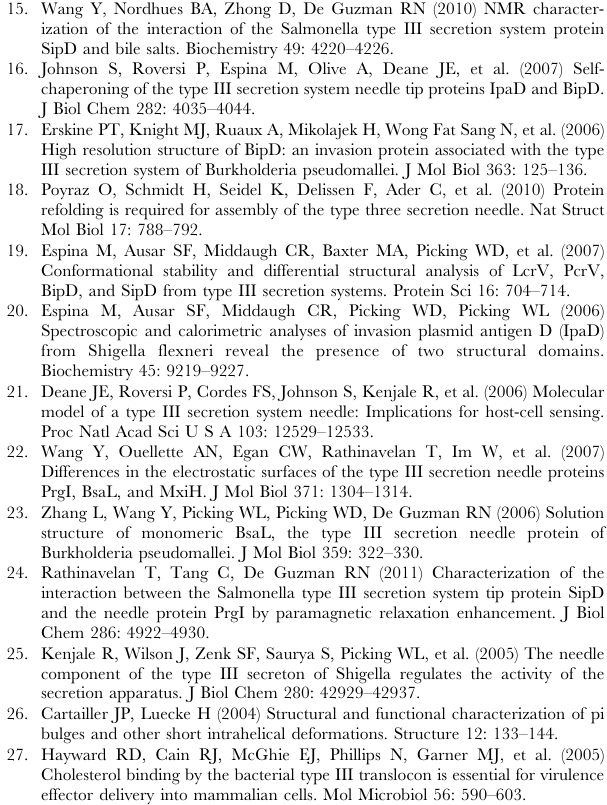
A and B show a p -bulge, chain C and D are partially destabilized and kinked at the same position as SipD in the fusion protein. Figure S12 Co-crystal structure of PrgI-SipD D D1 with deoxycholate. Left: Ribbon presentation of the PrgI-SipD D D1 fusion protein (chain B, SipD D D1 : green, PrgI: blue) in complex with deoxycholate (yellow); Right: Bound deoxycholate in the same orientation as on the left shown with superimposed composite 2fo-fc density map (blue) contoured at 1 s .